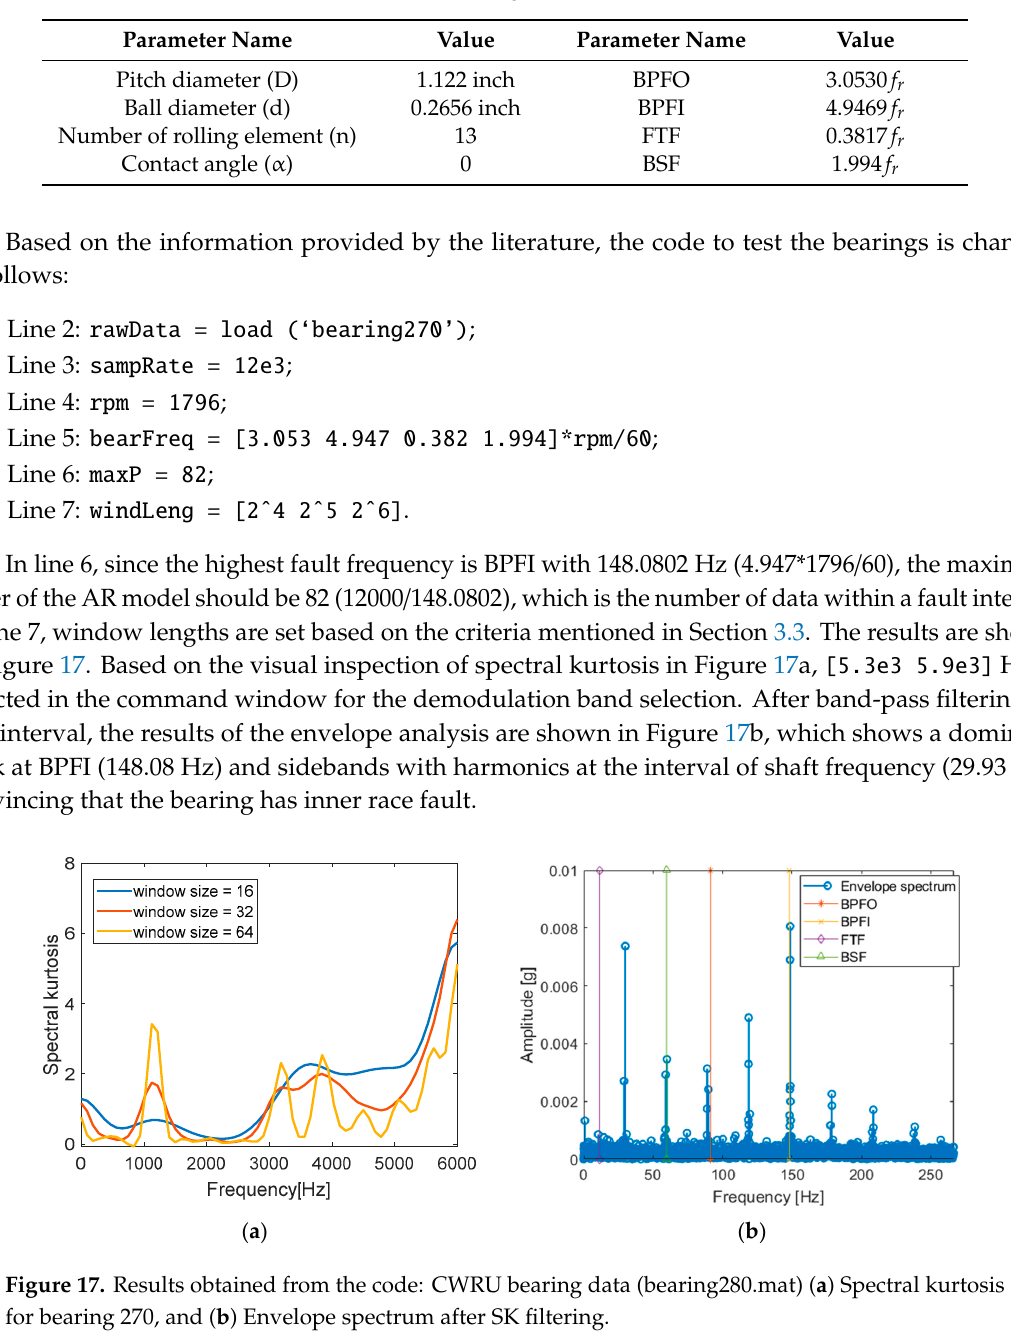
Table 4. Bearing information.